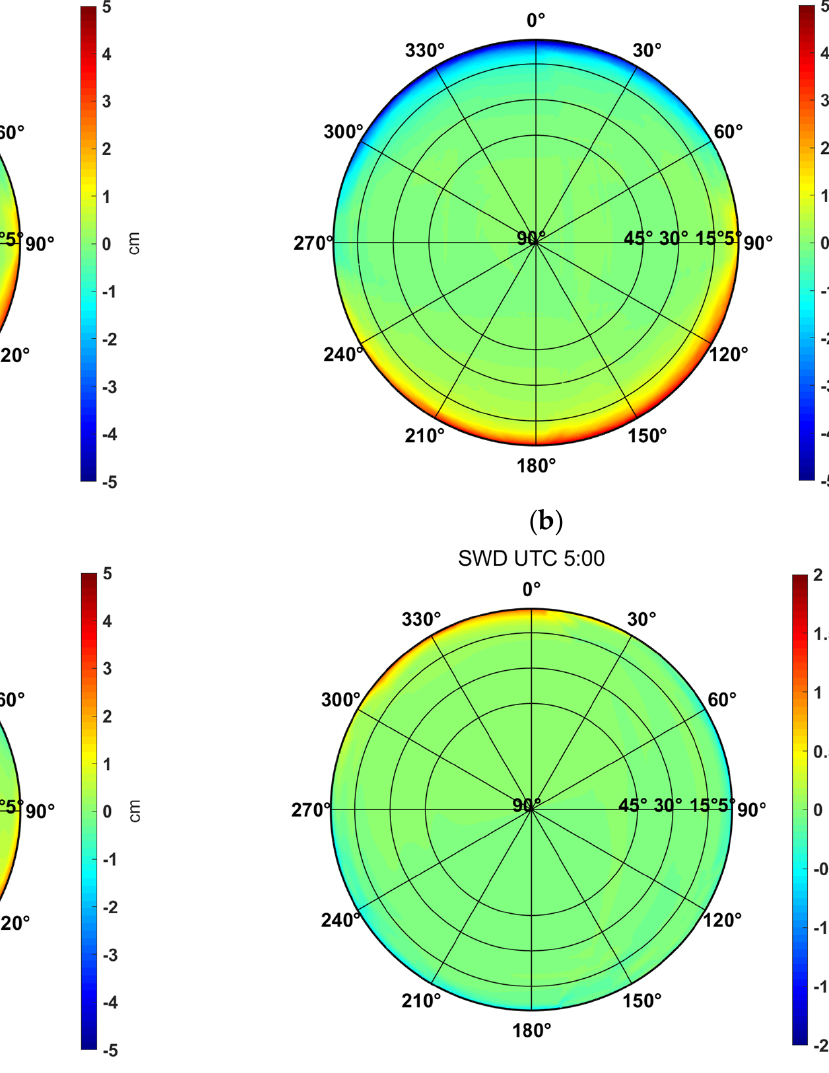
Figure 8. The asymmetry of ray-tracing slant delays calculated by removal of the mean value of each elevation, for the IGS station SHAO located in Shanghai on 26 December 2018. ( a ) SHDs at 00:00 UTC, ( b ) SHDs at 05:00 UTC, ( c ) SWDs at 00:00 UTC, ( d ) SWDs at 05:00 UTC. Please note the difference between the bound of the colorbar.